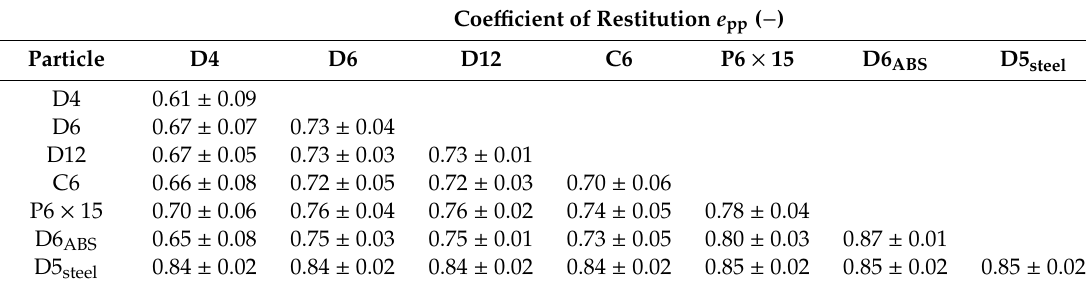
Table 12. Results of particle-particle CoR